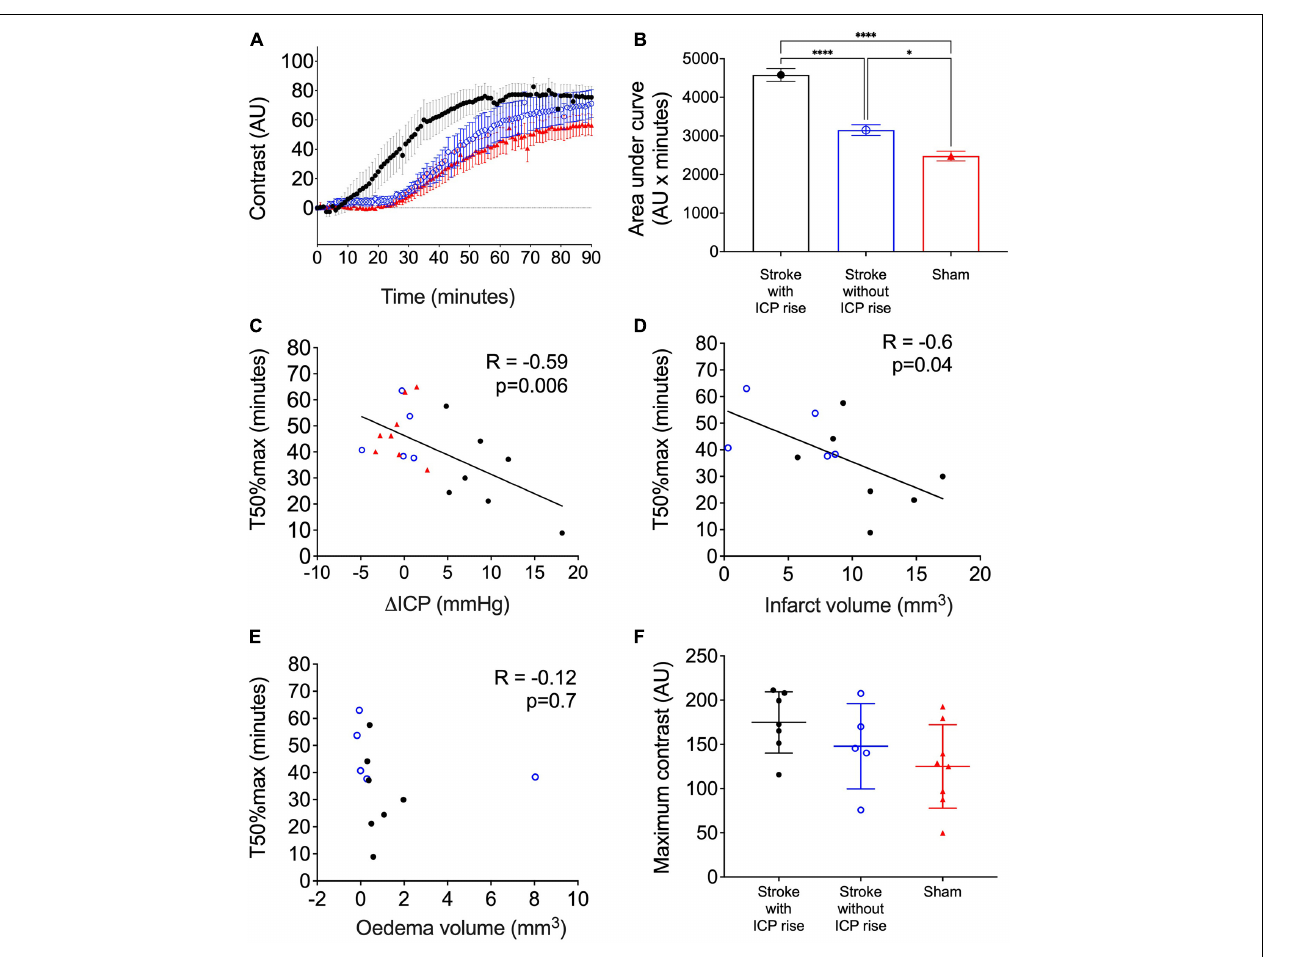
Frontiers in Molecular Neuroscience |